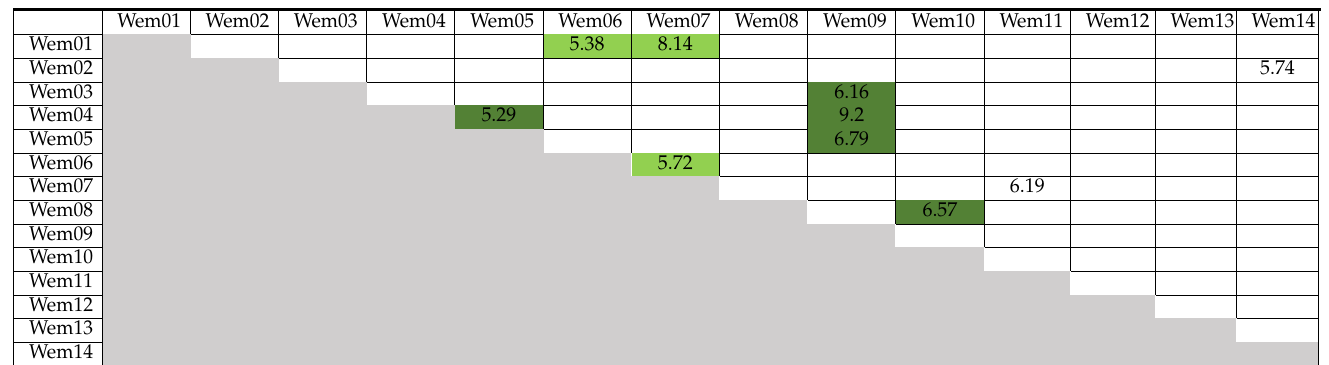
Table 1. Correlation matrix for Wem Moss samples Wem01–Wem14 showing t values exceeding 5.0. Site chronologies and their individual components are distinguished using the following colours: WEM2_2—lime green, WEM4_1—dark green.